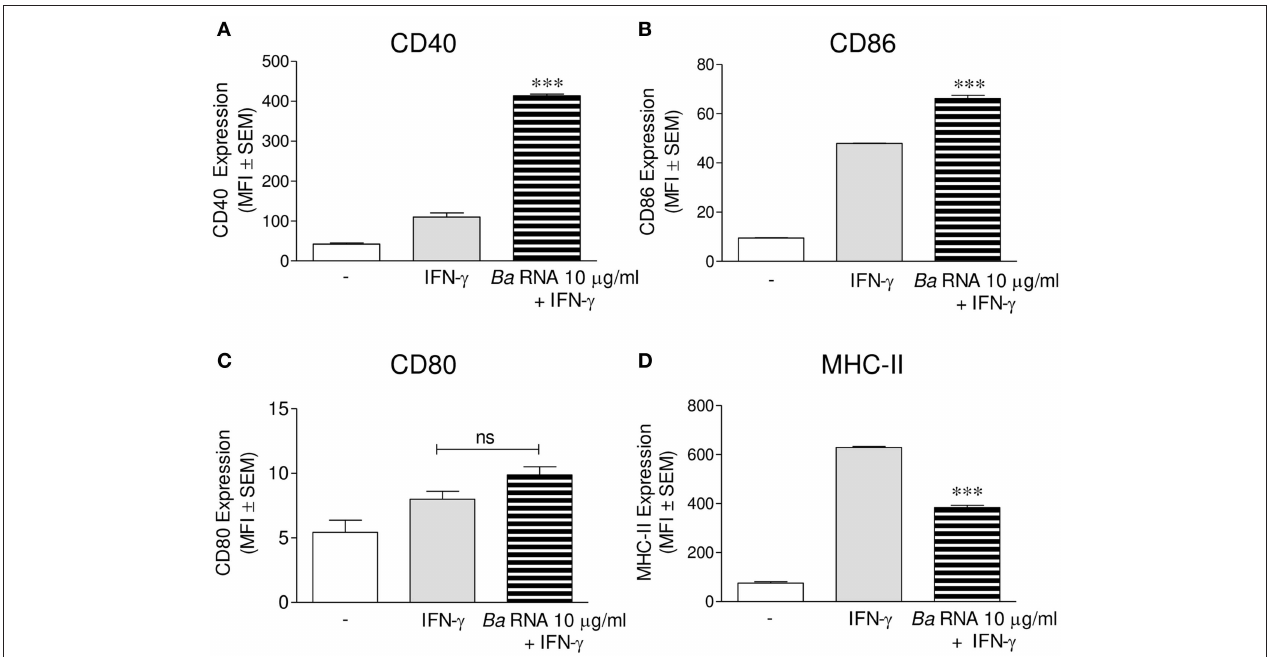
FIGURE 2 | B. abortus RNA does not down-modulate co-stimulatory molecules. (A–D) THP-1 cells were treated with B. abortus RNA (10 µ g/ml) in the presence of IFN- γ for 48h. CD40 (A) , CD86 (B), and CD80 (C) expressions were assessed by flow cytometry. MHC-II expression was determined as a control (D) . Bars represent the arithmetic means ± SEM of five independent experiments. MFI, mean fluorescence intensity; ns, non-significant. *** P < 0.001 vs. IFN- γ -treated cells.